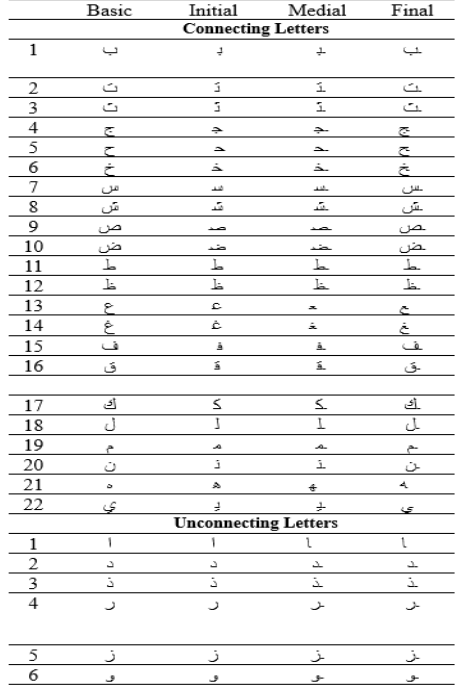
Table 2. Arabic word forms of partially con- nected and unconnected 3-letters, 4-letters and 5-letters (- represents a within word Space, □ represents a Con- necting letter, □ represents an Unconnecting Table 1. Arabic letters (connecting, unconnect- ing) in different shapes as a function of word-position